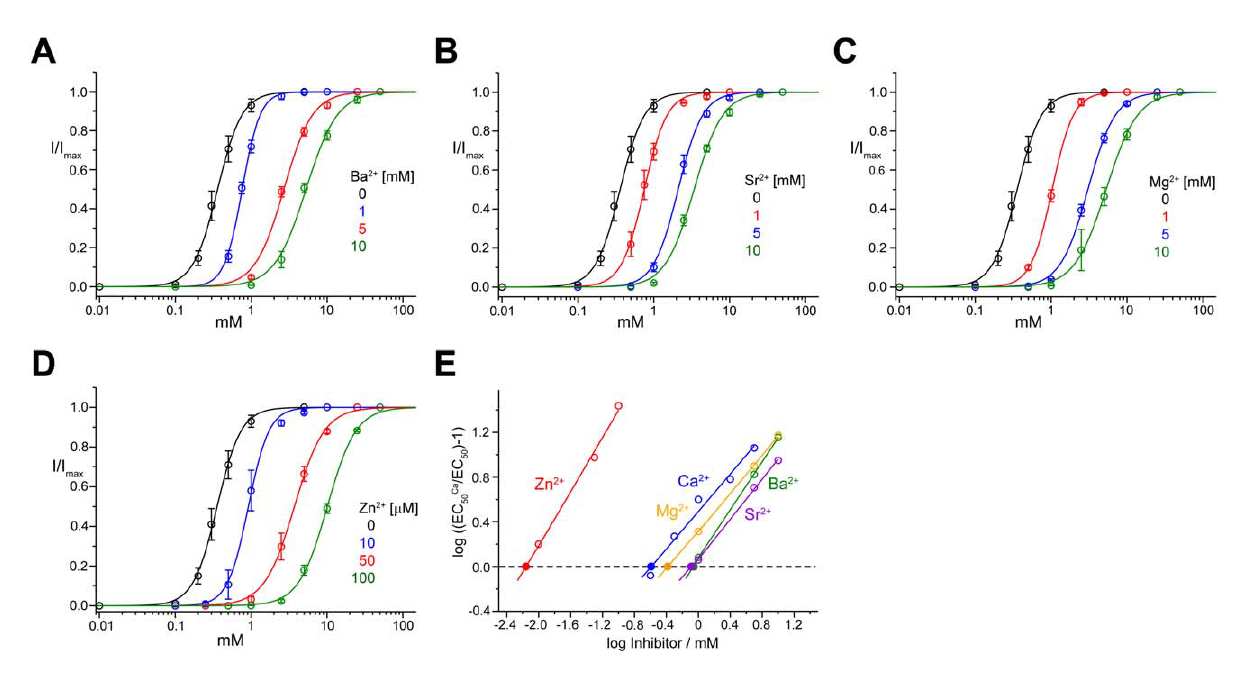
Figure 2. Inhibition of ELIC by different divalent cations. Dose–response relationships of ELIC activated by cysteamine at different concentrations of Ba 2 + (A), Sr 2 + (B), and Mg 2 + (C) and ELIC activated by propylamine at different concentrations of Zn 2 + (D). (E) Schild plot quantifying the inhibition by different divalent cations. EC 50 values were obtained from fits to data shown in panels (A–D). Potencies of the Antagonists (pA values) were obtained by linear regression, and the intersection with the x-axis is indicated. The data presented in panels (A–D) are averages from at least 5 oocytes; errors are SD. The solid lines show fits to a Hill equation. Currents were recorded at 2 40 mV.